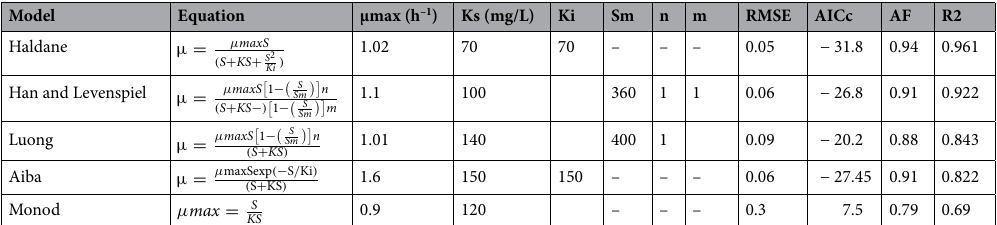
model would be good. The fit of the model was also expressed by the coefficient of regression R 2 .The predicted R 2 of immobilized Mucor sp.was 0.9837, which is consistent with the adjusted R 2 of 0.967. These findings indicate that the developed model was satisfactory and that the values of the independent factors were accurate with minimal error. The range of the projected response regarding the associated error was measured with adequate precision. A ratio of at least 4 is acceptable; however, a ratio higher than 4 is preferable. The ratio of 24.1 for Mucor sp. was high, indicating the reliability of the experimental data. Moreover, according to Supplementary Table 2, the coefficient of variation (CV%) values for Mucor sp. obtained in the study are relatively small, with 2.6. This indicated that the deviations between the experimental and predicted values were low. Figure 20c shows a graph of the Box-Cox diagram of model changes in MG removal (%) using Mucor sp. composite determined by a quadratic polynomial. The best lambda value (λ = 1.49) is between the two red vertical lines, so no data transformation is required. The red line shows the minimum (− 0.2900) and maximum (3.32) values, as well as lambdas at 95% confidence interval value. Interactive impact of pH on MG dye decolorization. The biosorption of Malachite green by the fungus was investigated for a pH range of 5–9. The maximum degree of decolorization (97.8%) was reached at a pH of 7.0, while at a pH of 9, the decoloriza- tion rate decreased to 40%. Figure 21a,b shows that the efficacy of dye decolorization using immobilized Mucor sp. decreased with rising pH levels. Moreover, Fig. 21c shows that the removal efficiency was 54% at a pH of 5.0 and 30 °C, and it improved to 87.8% at a pH of 7 and 30 °C. Similar findings were made by Ref. 64 , who discov- ered that the efficiency of decolorization of Malachite green using Aspergillus niger was about 97% at a pH of 7. Interactive impact of temperature on MG dye decolorization. Various environmental factors influenced the deg- radation of Malachite green using Mucor sp. This fungal strain degraded Malachite green effectively from 298 to 303 °C (Fig. 21c,e,f). Figure 21c,e,f shows that the rate of Malachite green decolorization increases as the tem- perature rises from 25 to 30 °C. Furthermore, Malachite green decolorization by Mucor sp. ON934589.1 reached a maximum of 91.54% at 303 °C. Conversely, as the temperature rose to 313 °C, the decolorization activity decreased (53%) due to the loss of cell viability or inactivation of the decolorizing enzymes 65 . Arunprasath et al. 4 observed that the optimum temperature (30 °C) was the optimum temperature for the decolorization (92%) of Malachite green dye by Lasiodiplodia strains. Interactive impact of concentration on MG dye decolorization. The adsorption behavior of MG was studied in concentrations of 5–200 mg/L at a pH of 7.0. In addition, 87.7–97.4% of Malachite green was eliminated by the immobilized fungus at 5–100 mg/L. The decolorization efficiency of Mucor sp . (ON934589.1) fell below 64% when the starting concentration of Malachite green approached 150 mg/L. These findings suggest that high concentrations of Malachite green impede the development of Mucor sp. (ON934589.1). Figure 21b shows the impact of the initial concentration and contact time on the removal of Malachite green dye using immobilized fungus. The immobilized fungus was suppressed at 150 mg/L of Malachite green due to the existence of sulfonic acid on the aromatic ring formed in the medium by the increased concentration of Malachite green, which inhib- ited the nucleic acid synthesis and microbial cell proliferation 66 . The findings of this investigation corresponded with those of Ref. 67 , who found that Aspergillus fumigates immobilized in polyurethane foam had an optimum Malachite green decolorization percentage of about 97.52% (40 mg/L),which reduced to 23% at 70 mg/L. Impact of contact time on MG dye decolorization. At the optimum dye concentration (50 mg/L) and biosorbent dosage (6 g/L), the impact of contact time on adsorption was examined from 24 to 72 h. Figure 21a,d shows the influence of contact time on the elimination of the MG dye. The range of the MG’s adsorption efficiency was 18 to 72 h, corresponding to 72% and 97%, respectively. Based on the data, 40 h was determined to be the equi- librium time in the sorption process because no further improvement was observed after reaching maximum adsorption. The high removal efficiency at the beginning of the contact time of 40 h was due to the large surface area available for dye adsorption during the initial stage, and the adsorbent’s capacity gradually depleted over time, as the few remaining vacant surface sites became tough to occupy because of repulsive forces between the solute molecules on the solid and bulk phases 68,69 . Our results correspond with those of Ref. 70 , who observed that Lasiodiplodia sp . could decolorize 81% of Malachite green within 36 h.